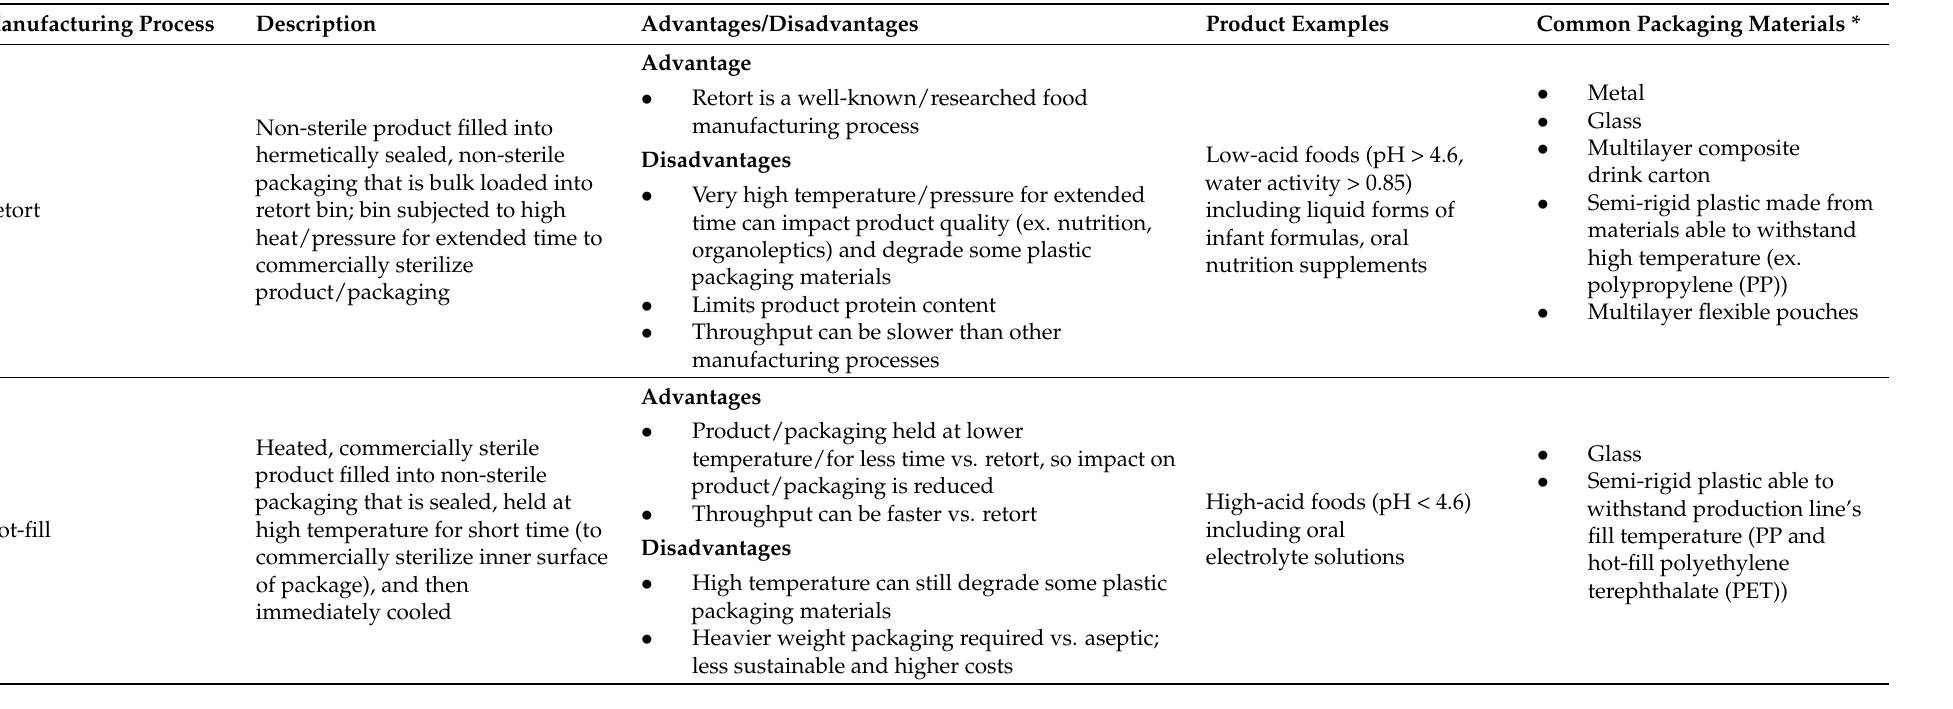
Table 3. Manufacturing processes used for producing specialized products for vulnerable populations